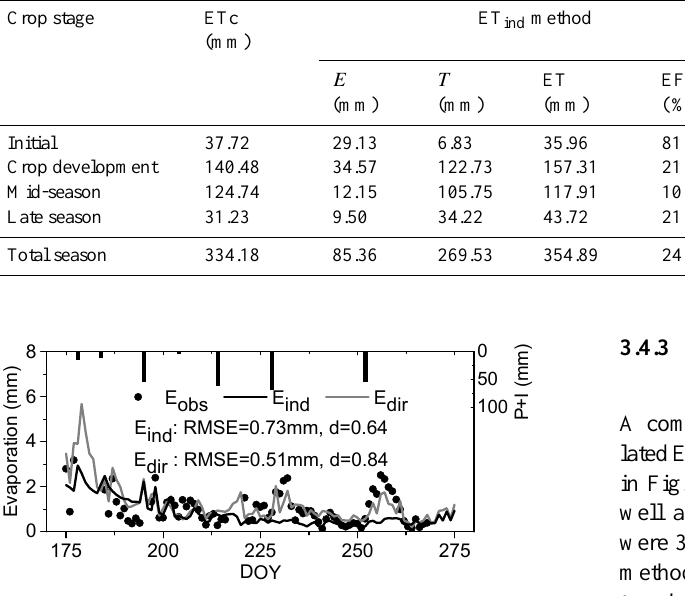
Figure 8. Daily variation in observed and simulated soil evaporation based on the two ET simulation